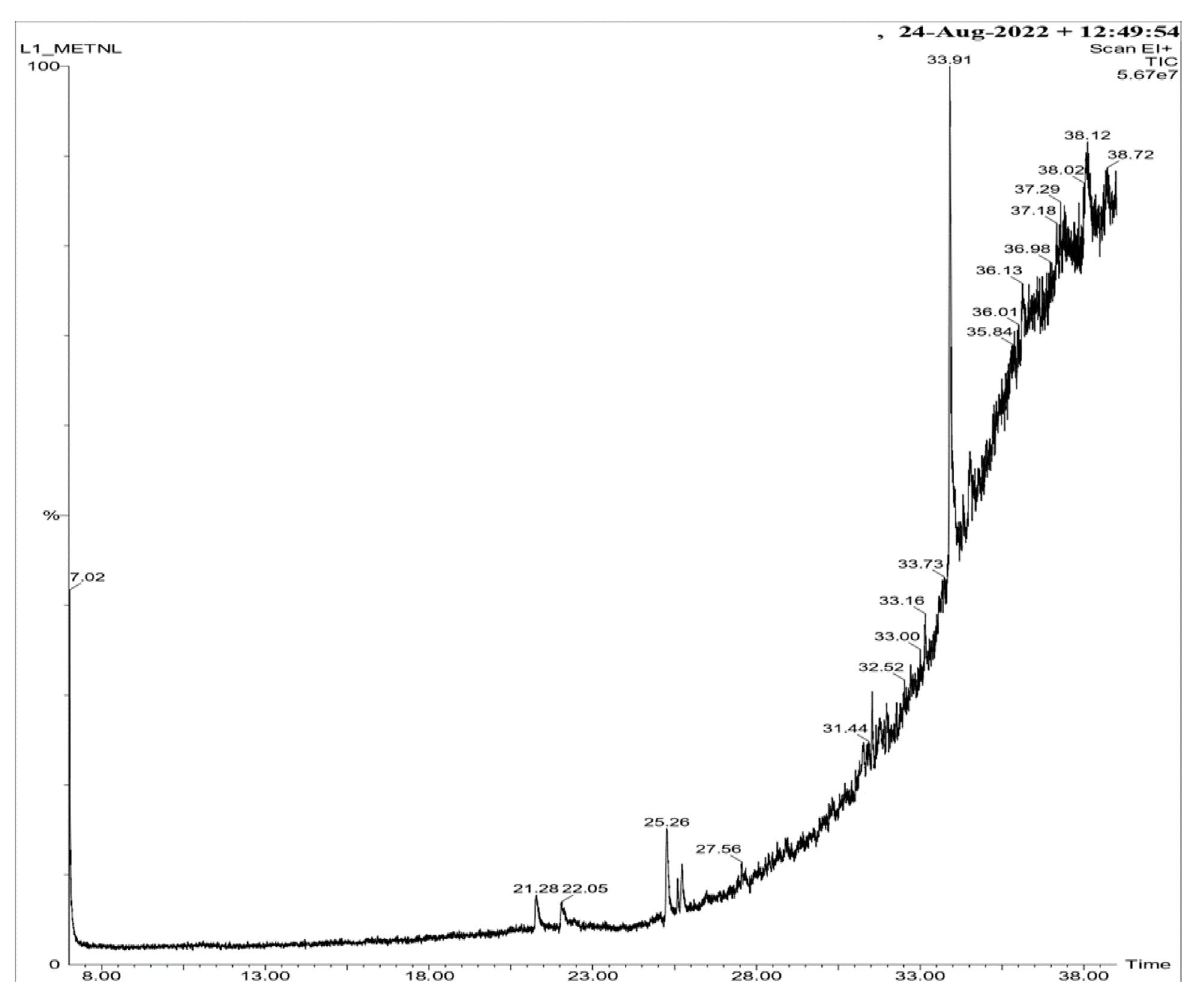
Fig. 12 GC‑MS chromatograms of methanol extract of T.